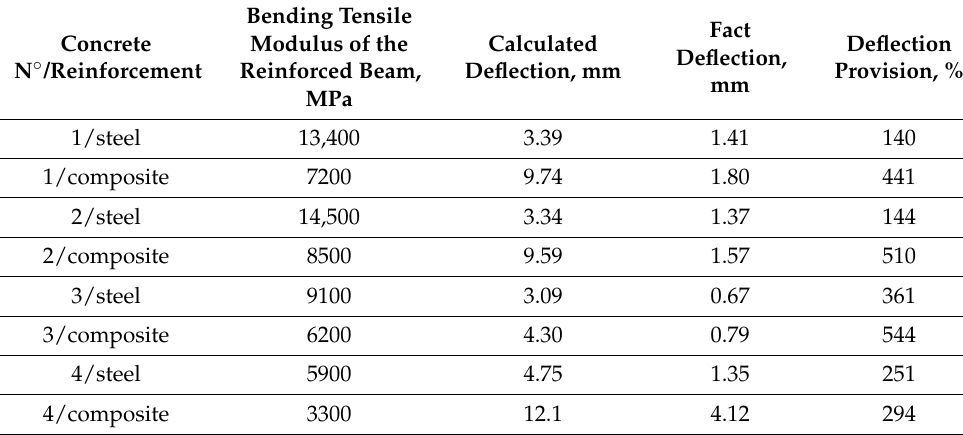
Table 2. Calculated and fact deflections of concrete